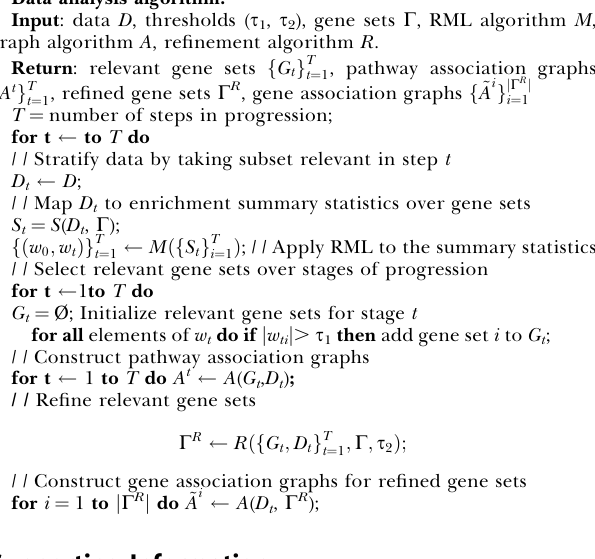
Table S1. Database of Gene Sets Table S2. Gene Sets Significant in Prostate Cancer Progression Table S3. Refined Gene Sets from the Prostate Cancer Analysis Table S4. Gene Sets Significant in Melanoma